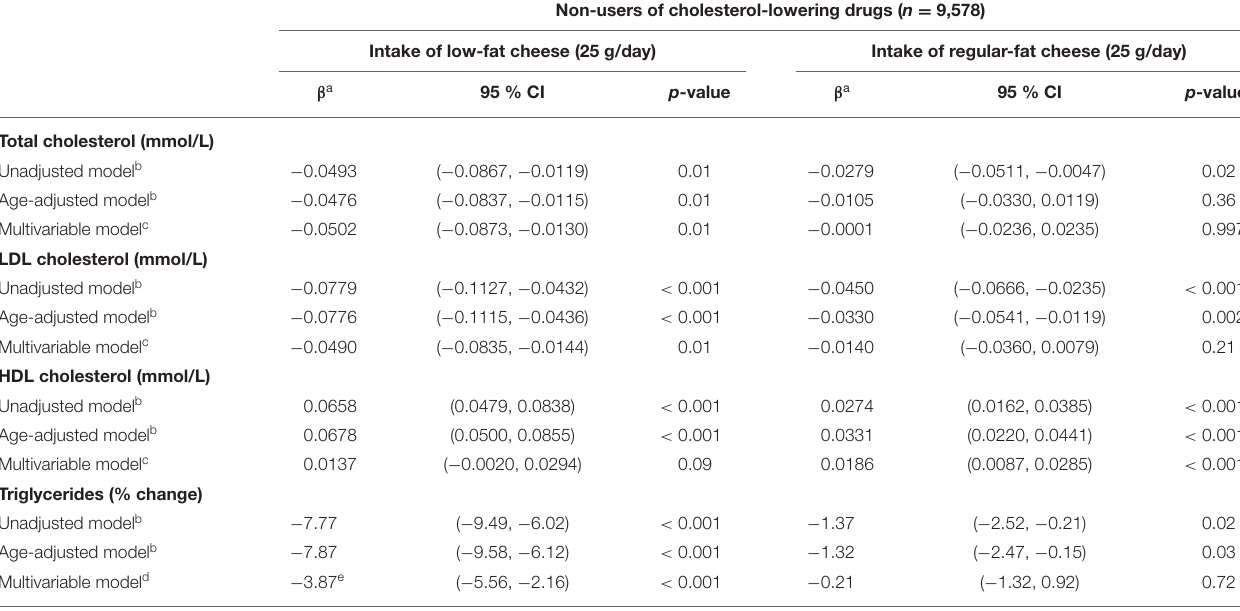
TABLE 6 | Linear regression coefficients for the associations between blood lipids and intake of low-fat cheese and intake of regular-fat cheese among non-users of cholesterol-lowering drugs ( n = 9,578). The Tromsø Study: Tromsø7. Non-users of cholesterol-lowering drugs ( n =